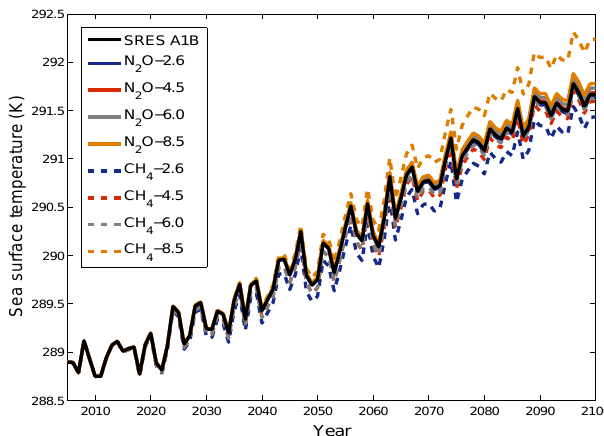
Fig. 2. Global-, annual-mean SSTs. The SRES A1B SSTs were used in all eight CCM simulations. The other SST series were cal- culated individually for each GHG concentration scenario using